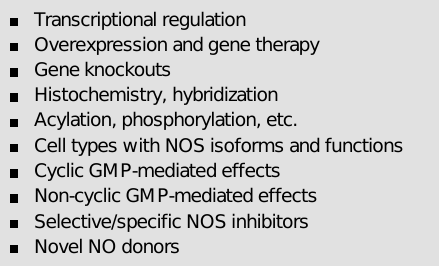
Table 2 - Areas of active NO